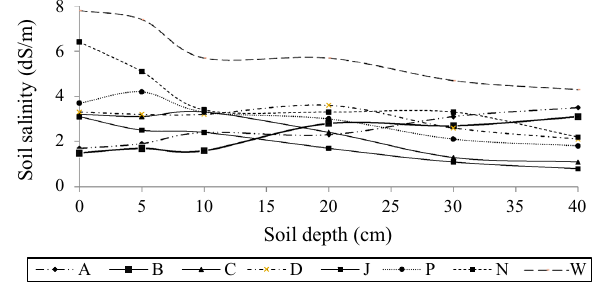
e (dS/m) variation in the eight irrigation